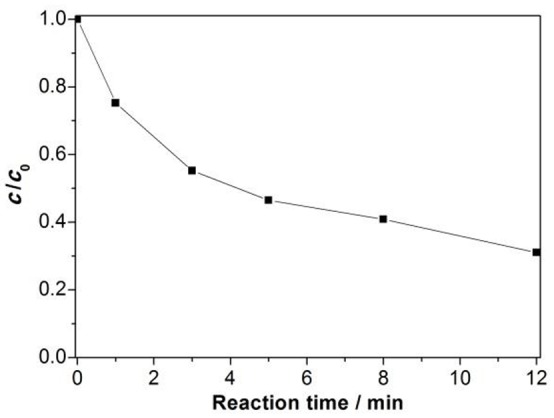
Time course of H2O2 concentration in the presence of MNP nanozymes (5 mg L−1).